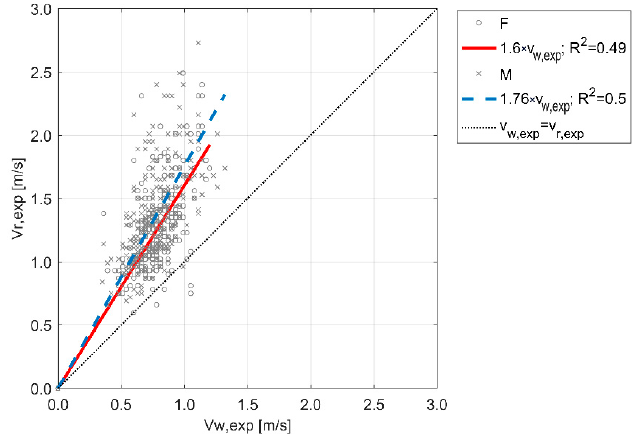
Figure 3. Database characterization depending on v w,exp and v r,exp pairs, for each individual, by distinguishing females (continuous red line) and males (dashed blue line) linear regressions and related samples.